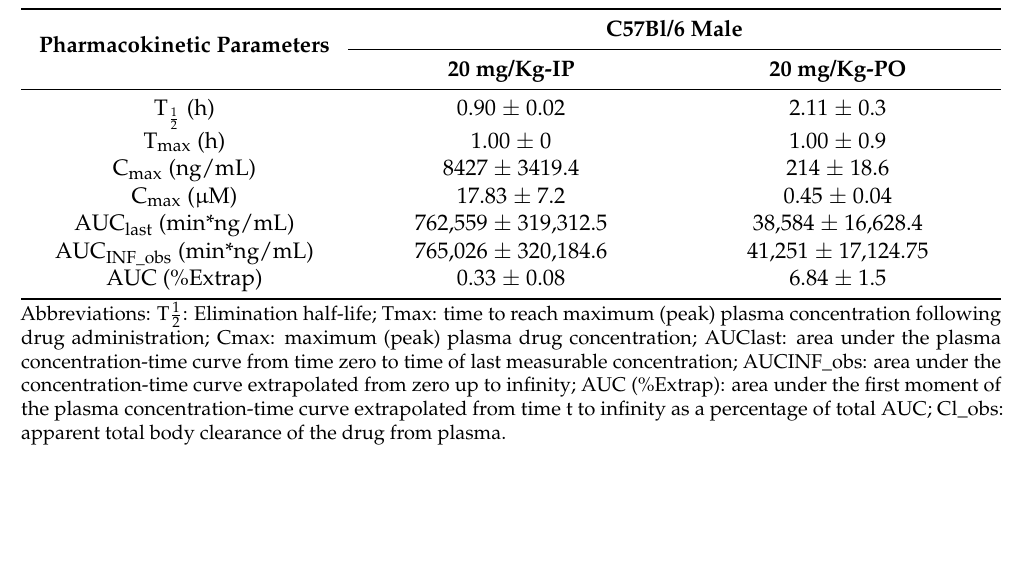
Figure 5 : In vivo pharmacokinetic and toxicity profile of momordicine-I. ( A ) Concentration-time profile of momordicine- I in C57Bl/6 male mice at 20 mg/kg single dose administered by IP injection or oral gavage (PO). Data is from n = 3 mice